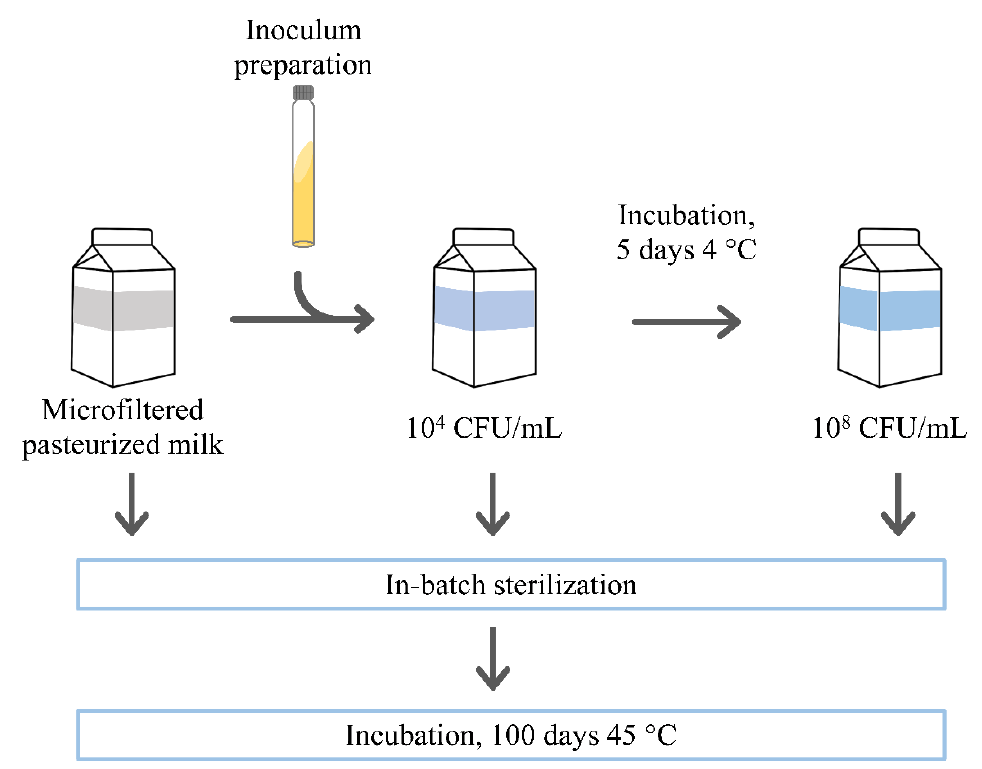
Figure 1. Preparation of experimental milk samples.